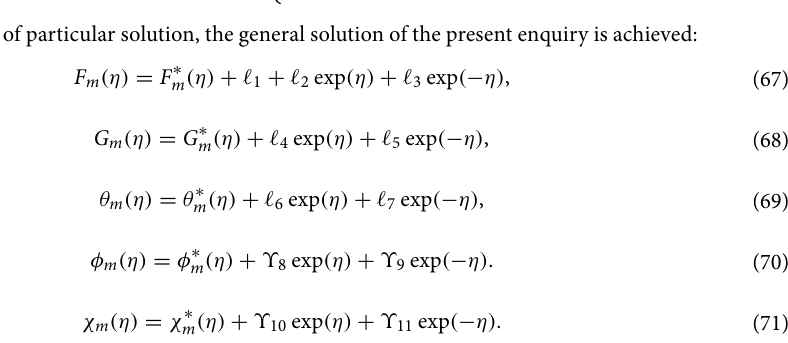
φ . Figure 4 signifies the deviation of velocity outline in x direction under the impact of Fr . From the Fig. 4, − it is noted that the velocity curve in x direction declined due to the higher values of the Fr . The factor Fr has − a nonlinear relation against the fluid flow. Further, as the value of Fr is rises, in the motion of fluid